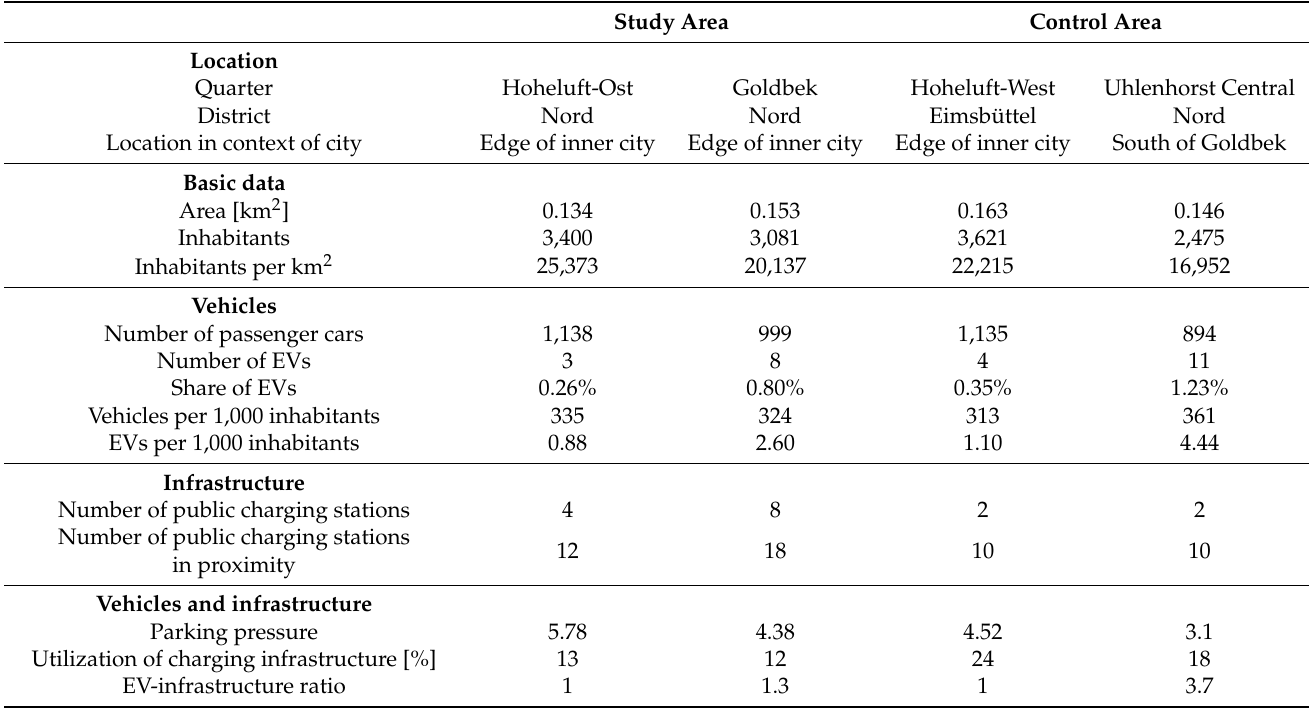
Table 3. Relevant basic data in study area and control area (2021).